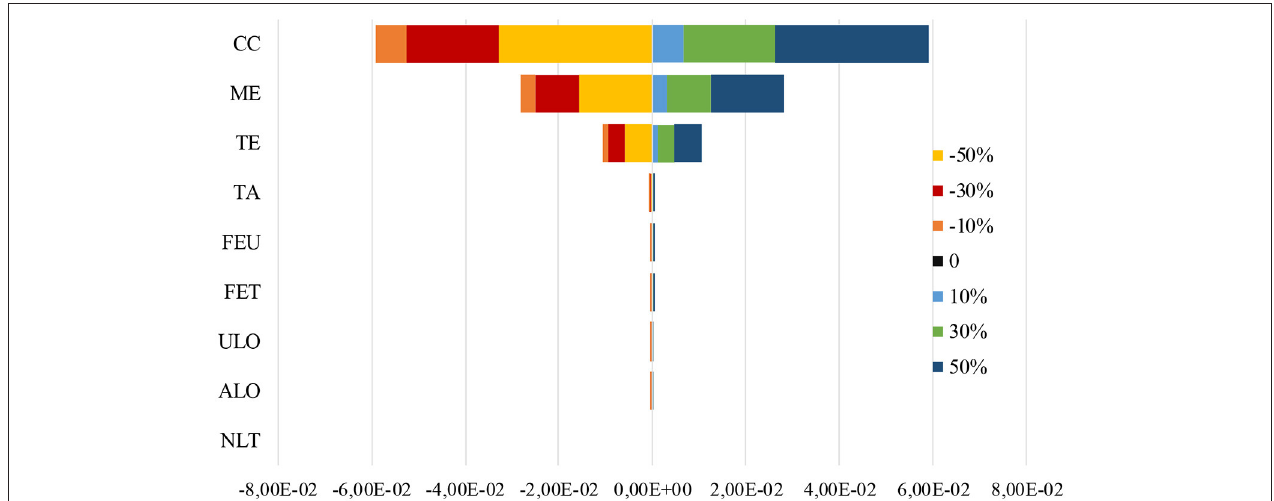
FIGURE 7 | Sensitivity analysis results across environmental influence categories due to change in item volume in operations